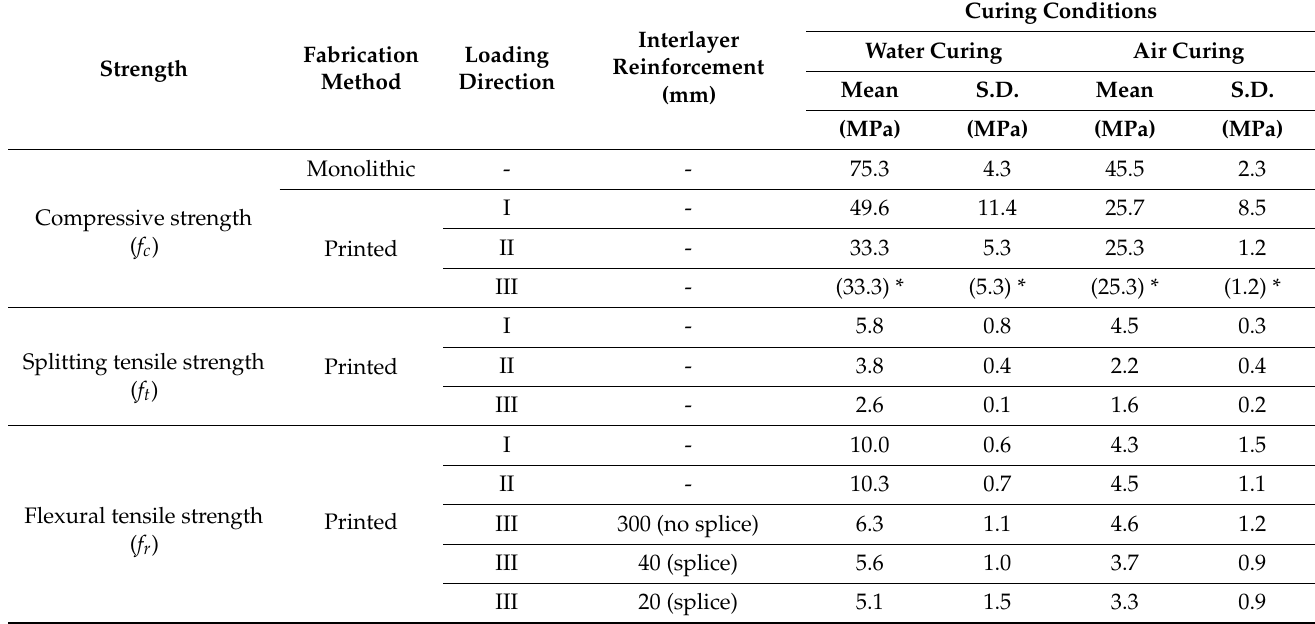
Table 2. Strength properties of the 3D-printed mortar.